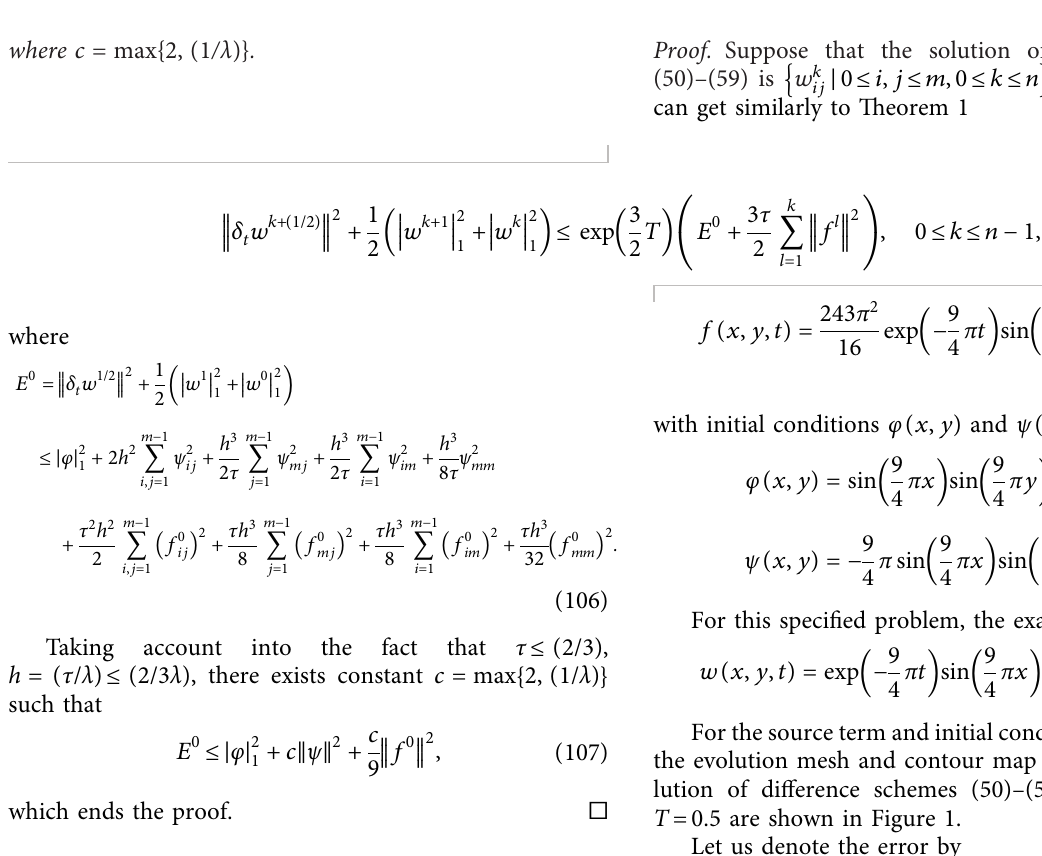
Figure 2: The curve of convergence order in Tables